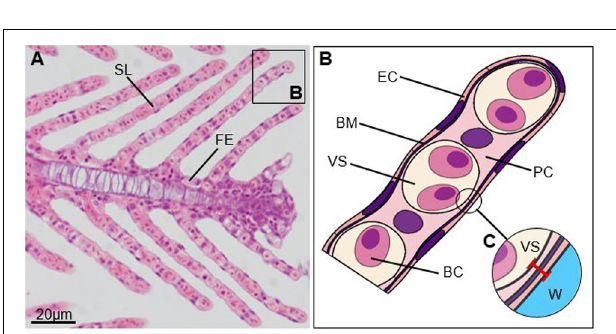
FIGURE 2 | Gill filament. (A) Micrograph of a primary lamella, sagittal section through cartilaginous support (Bouin’s solution, H&E), (B) scheme of the tip of a secondary lamella, and (C) gas diffusion distance (red line). SL, secondary lamella; FE, filament epithelium; EC, epithelial cell; BM, basal membrane; VS, vascular space; PC, pillar cell; BC, blood cell; W,